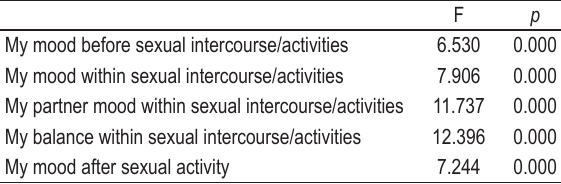
TABLE 6. Correlation between number of sexual intercourses per